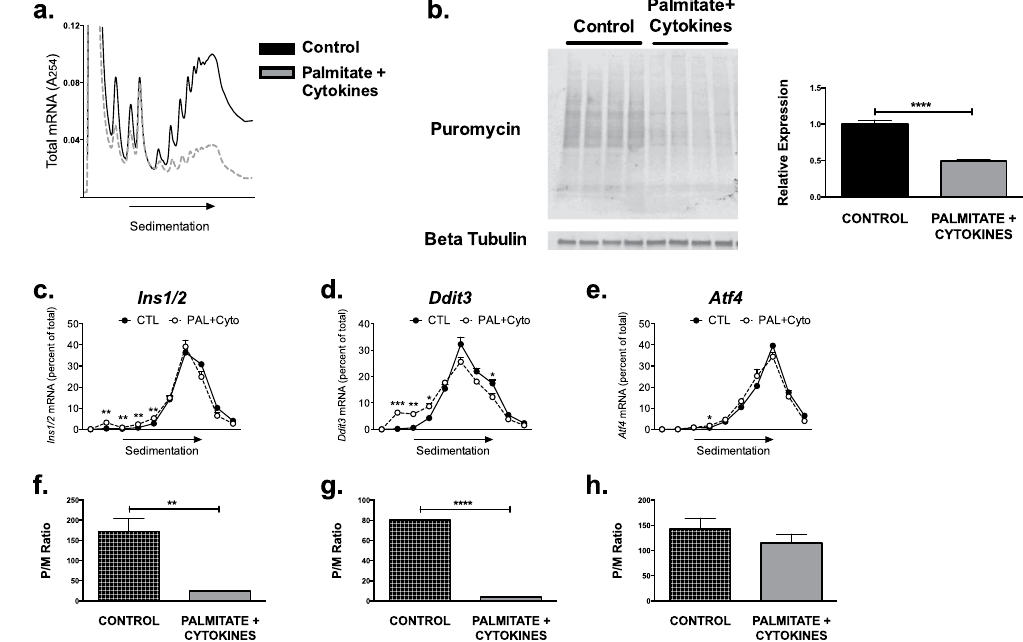
Figure 3. Modeling chronic β cell lipotoxicity to mimic in vivo effects of chronic HFD. MIN-6 β cells were treated with 40 hours of palmitate + a cytokine mix to mimic chronic lipotoxicity and inflammation (n = 4). ( a ) Representative global PRP tracing. ( b ) Puromycin incorporation of cells from both treatment groups, with quantification of total band intensities. ( c – e ) PRP analysis of individual transcripts for Ins1/2, Ddit3 , and Atf4 by fraction.( f – h ) Quantification of P/M Ratios for each transcript. * p < 0.05, ** p < 0.01, *** p < 0.001, **** p <